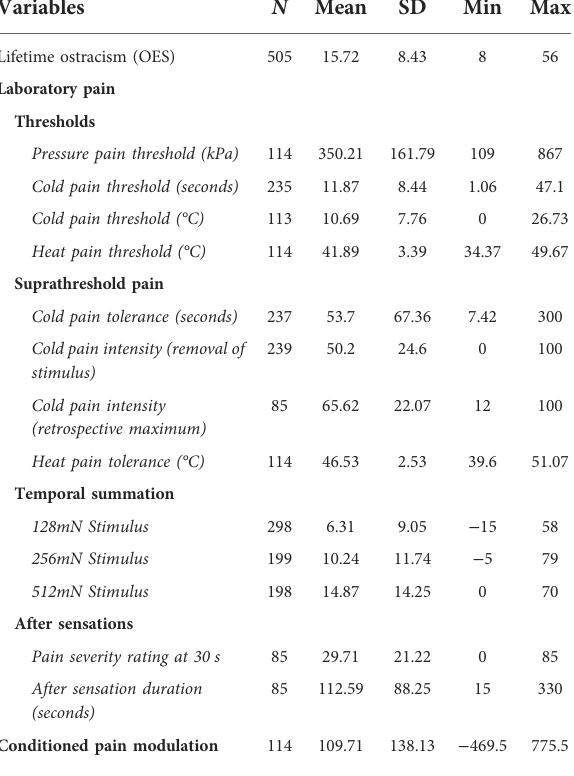
TABLE 3 Descriptive characteristics of lifetime ostracism and laboratory pain measures.